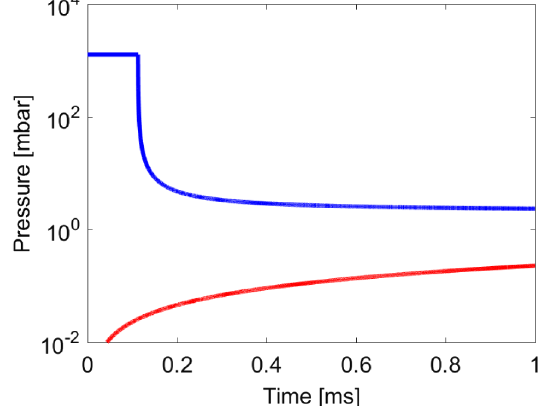
FIG. 1. Comparison of pressure vs time for gaseous helium produced by boiling LHe during a quench, showing normal LHe at 4K (blue) and superfluid LHe at 2K